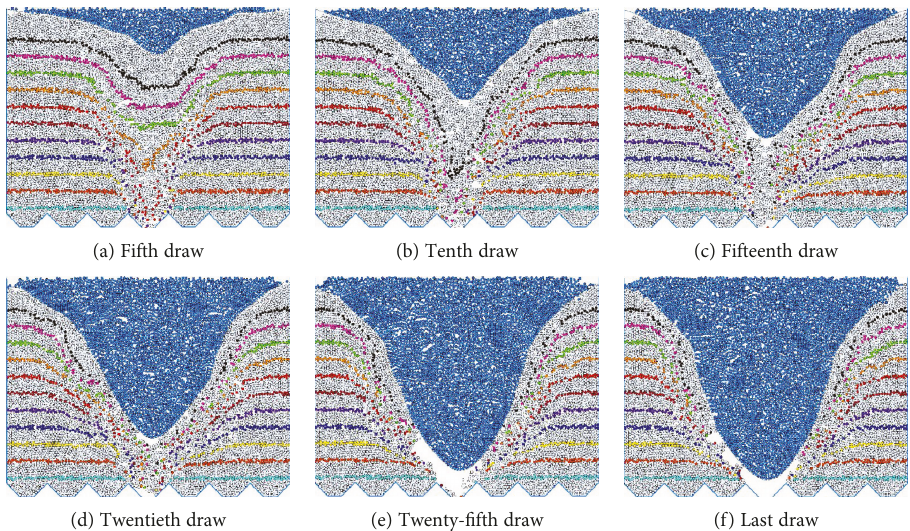
Figure 4: Flow pattern of the